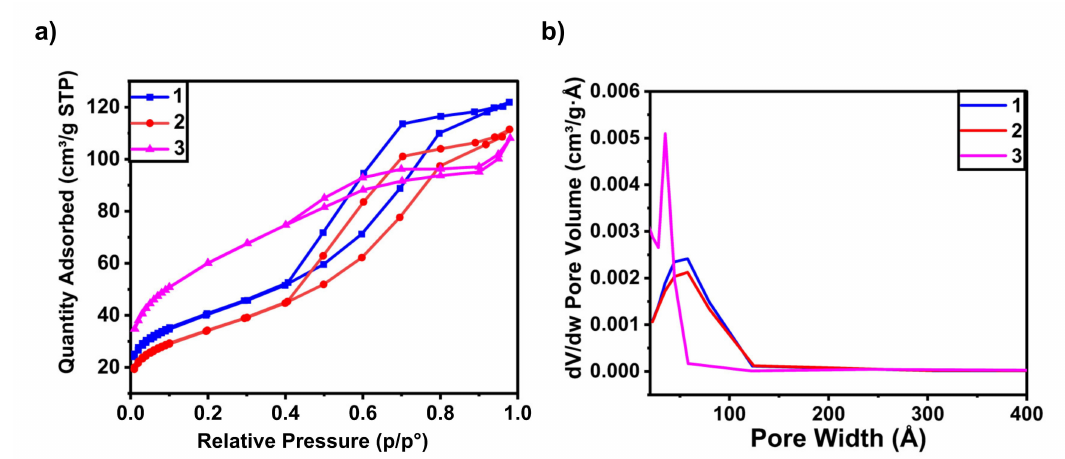
Figure 8. ( a ) N 2 adsorption/desorption isotherms at 77K of samples (1), (2) and (3); ( b ) their corresponding BJH mesopore size distribution curves of the samples (1), (2) and